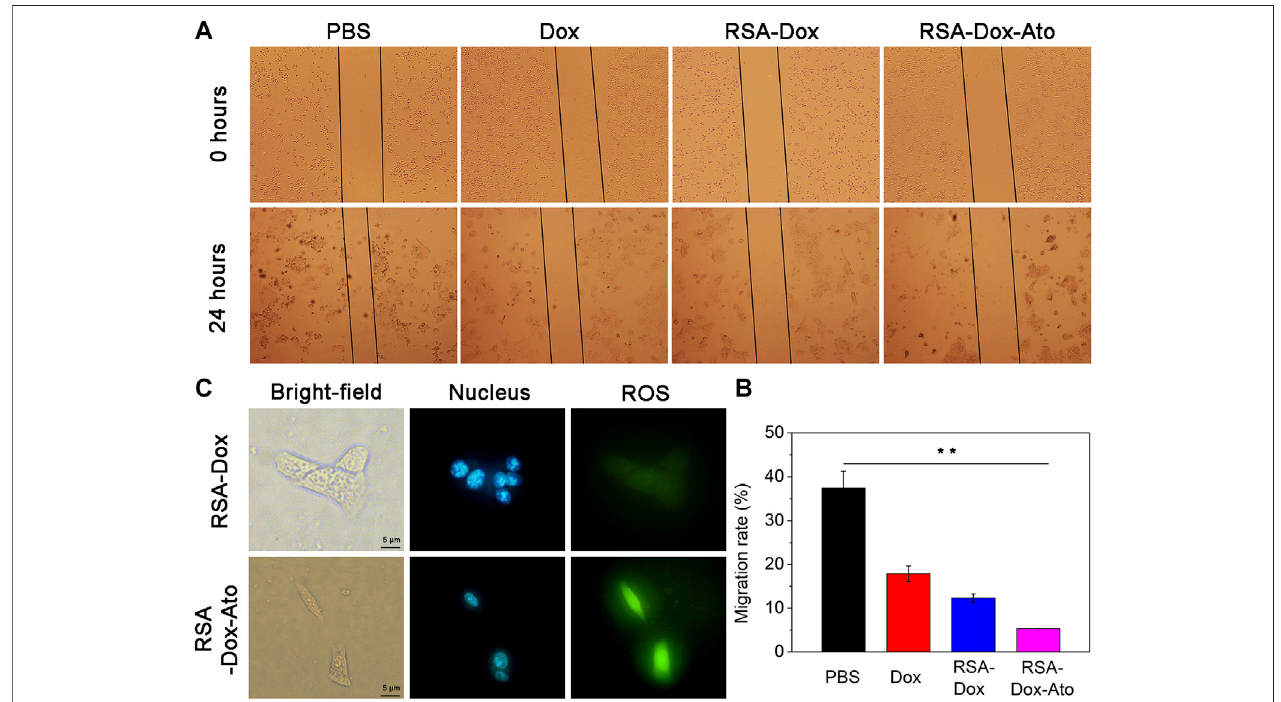
FIGURE3 | The effectsofSF-based nanomicelles on cell migration and hypoxia. (A) The effects of drugs on cell migration in 4T1 cells after treatmentwithin0 hour and24 hours(allcellswereobservedbymicroscopewitha4×objective); (B) Themigrationratewascalculatedaftervarious therapies; (C) TheimagesofSF-basedNPs against 4T1 cells hypoxia after various